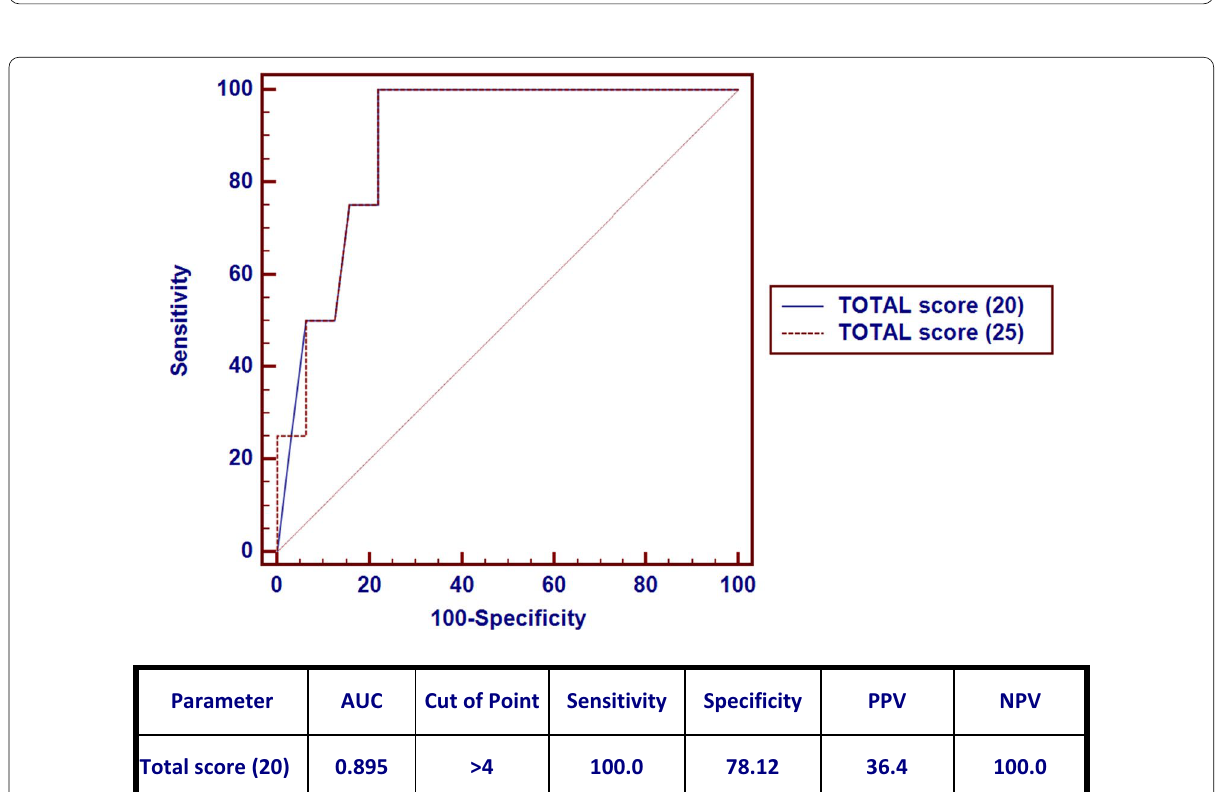
Fig. 4 ROC curve of CT‑SS with a total score of 20 as a predictor of severity of chest